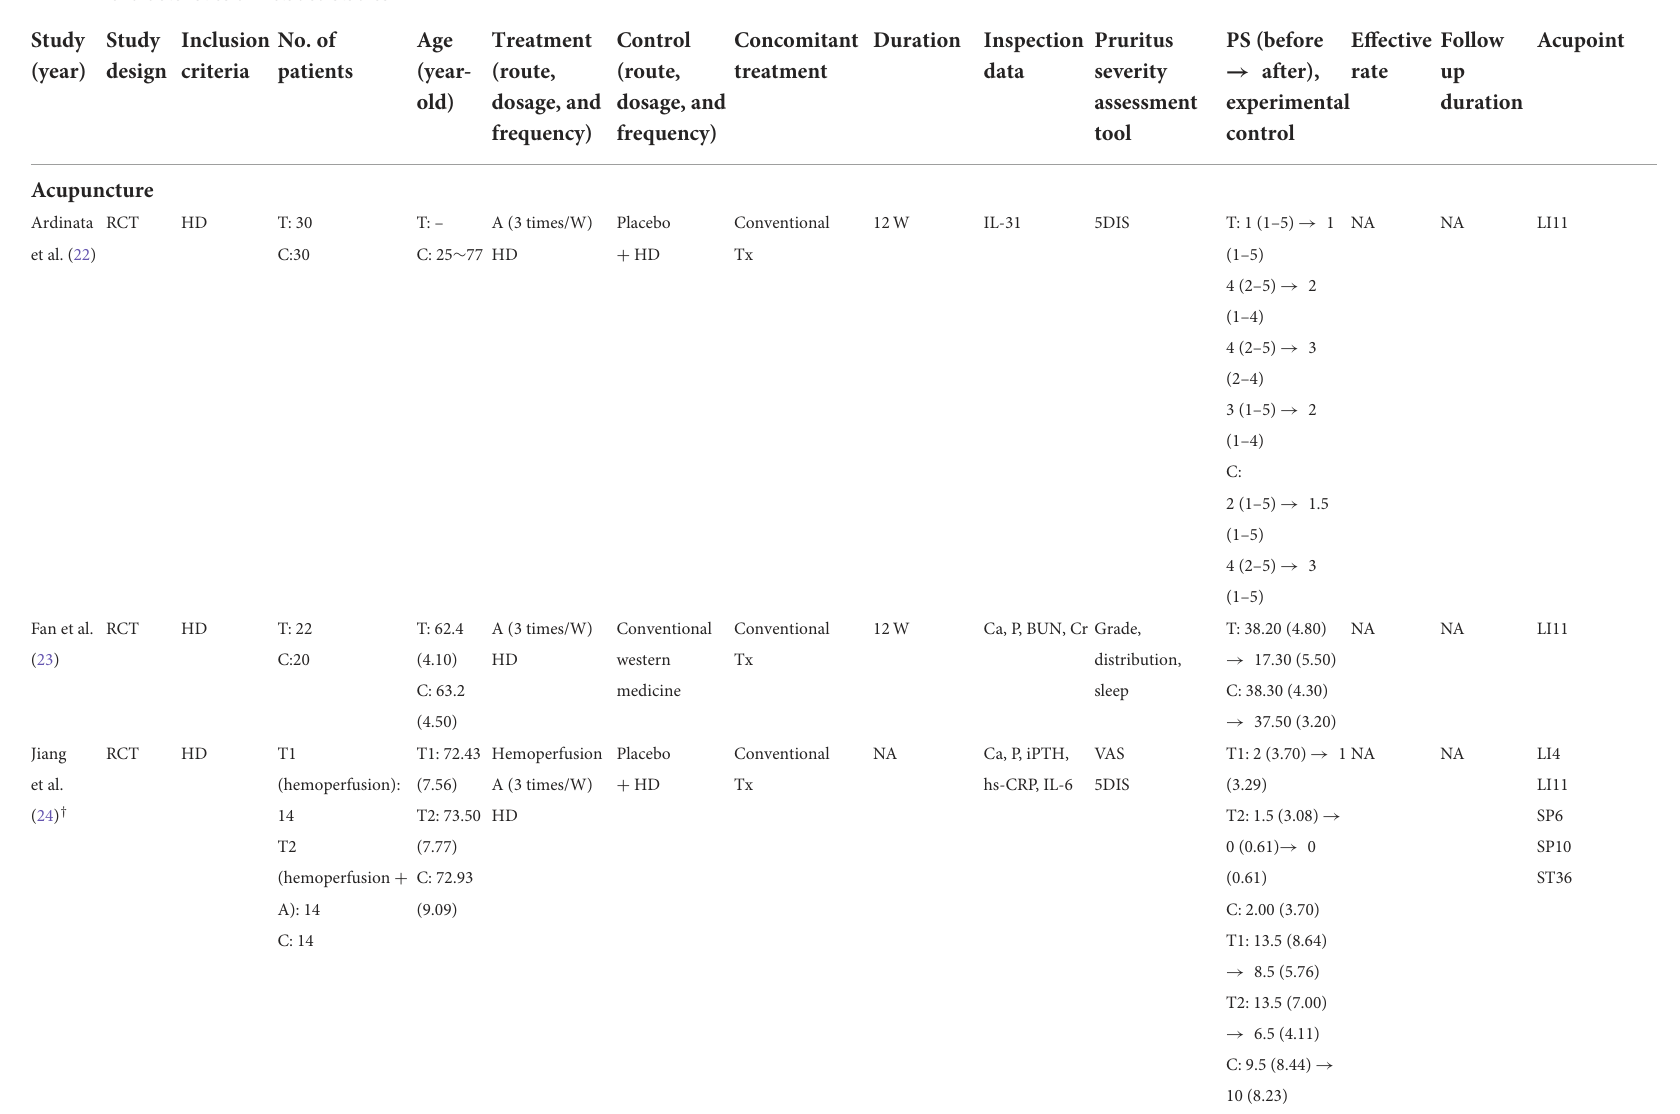
TABLE 1 Characteristics of included